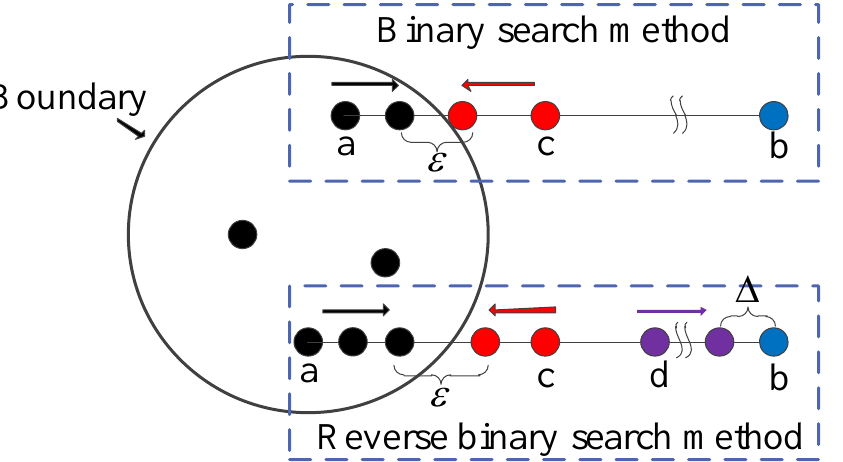
Figure 8. The difference between the binary search method and the reverse binary search method.